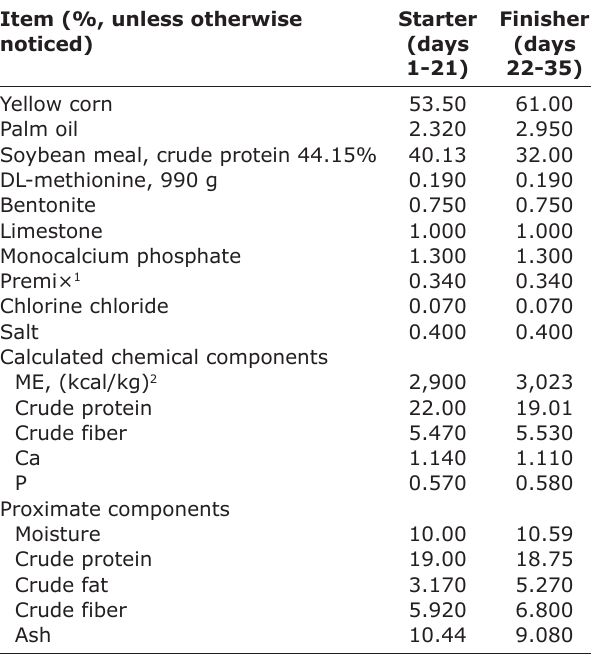
Table-1: Ingredients and nutritional compositions of feeds. Item (%, unless otherwise